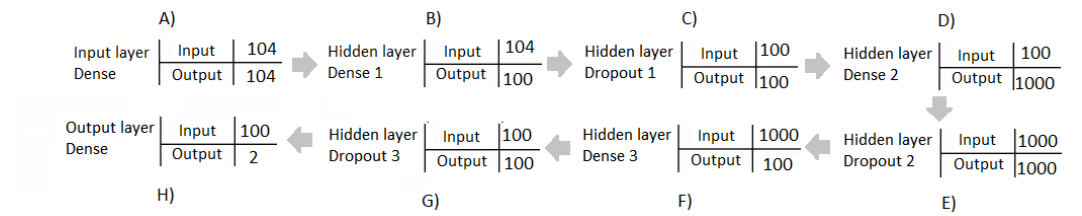
Figure 4. Diagram of the ANN